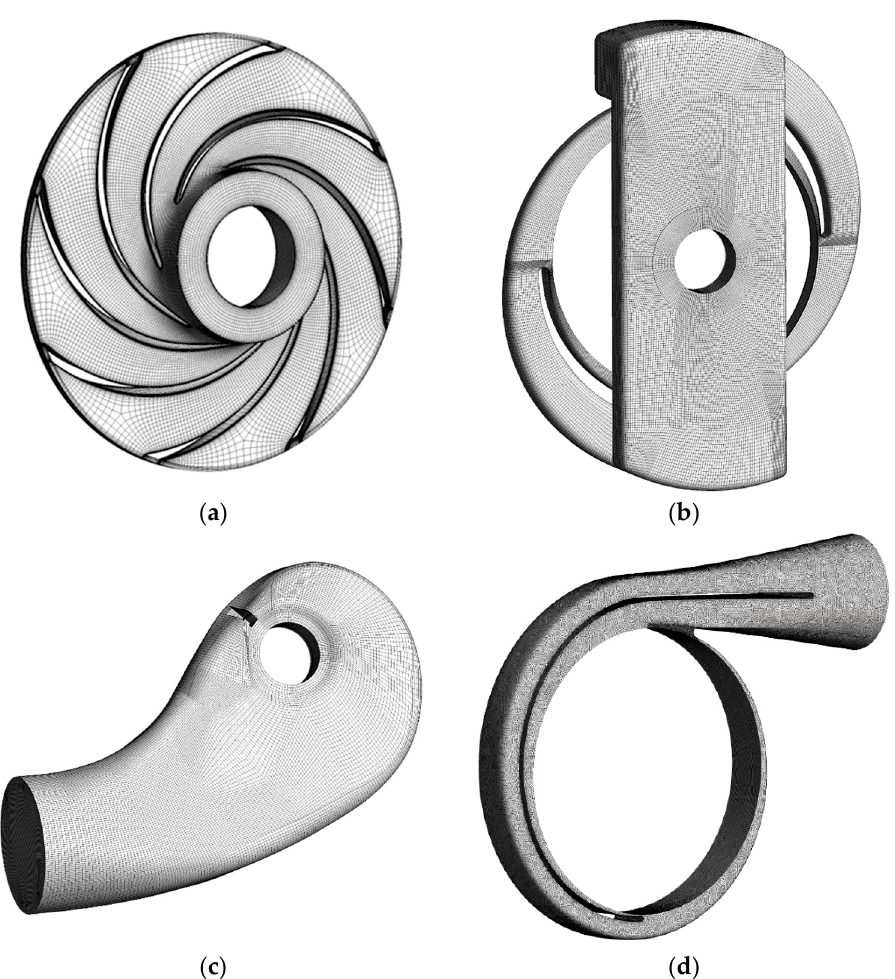
Figure 3. Meshes of the calculation domain: the impeller ( a ), the inter-stage flow channel ( b ), the suction chamber ( c ), and the volute ( d ).